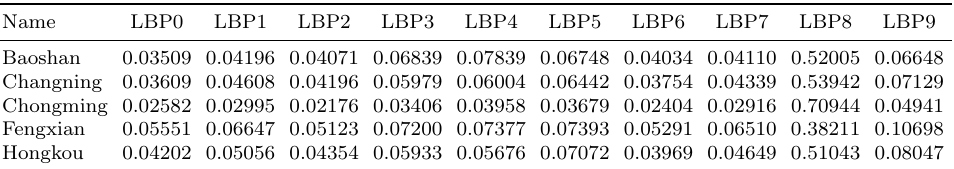
Table 7: Partial texture features identified in 1984